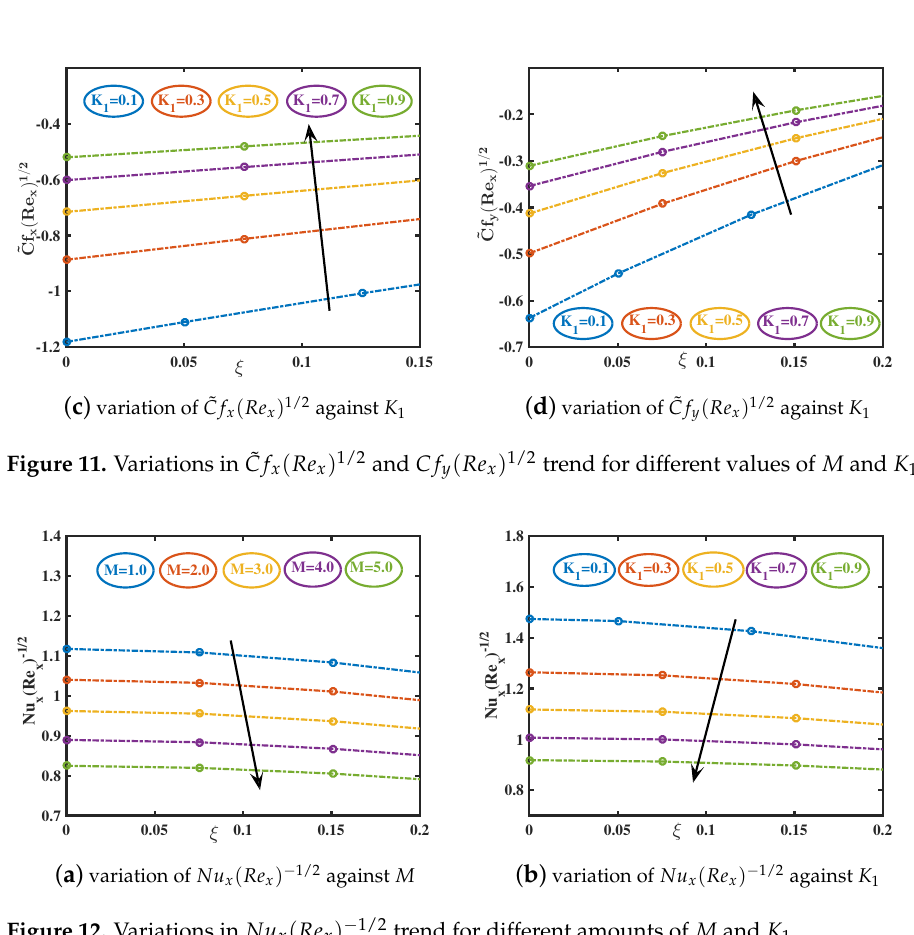
Figure 12. Variations in Nu x ( Re x ) − 1/2 trend for different amounts of M and K 1 . The rising values of the φ s boost the primary and secondary skin frictions. The ad- dition of nanoparticles in base liquid thickens the fluid and generate resistance. As a result, the Nusselt number Nu x ( Re x ) − 0.5 diminishes. The increment in the nanoparticle diameter originates a regression in both the skin friction coefficients, while a progression in the Nusselt number is observed. The increased diameter of copper nanoparticles re- sults in the reduction of fluid viscosity, ultimately encouraging the nanoliquid’s velocity. Furthermore, the local Nusselt number Nu x ( Re x ) − 0.5 increases for higher values of d n . The higher values of s p appreciate the heat transfer coefficient. Table 4. Fluctuation in Nusselt number ( Nu x ) , skin friction coefficients ( ˜ Cf x , ˜ Cf y ) values for various values of